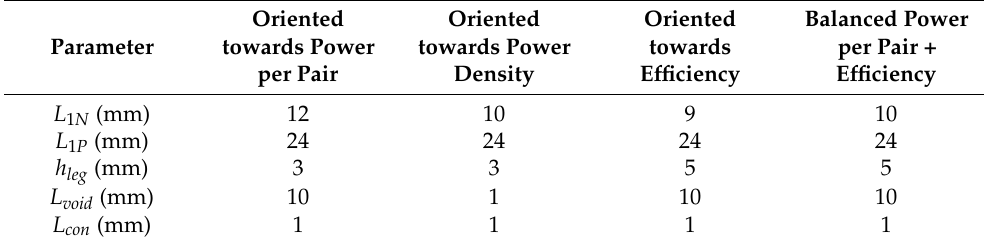
Table 1. Geometric parameters selected for the optimized geometries.